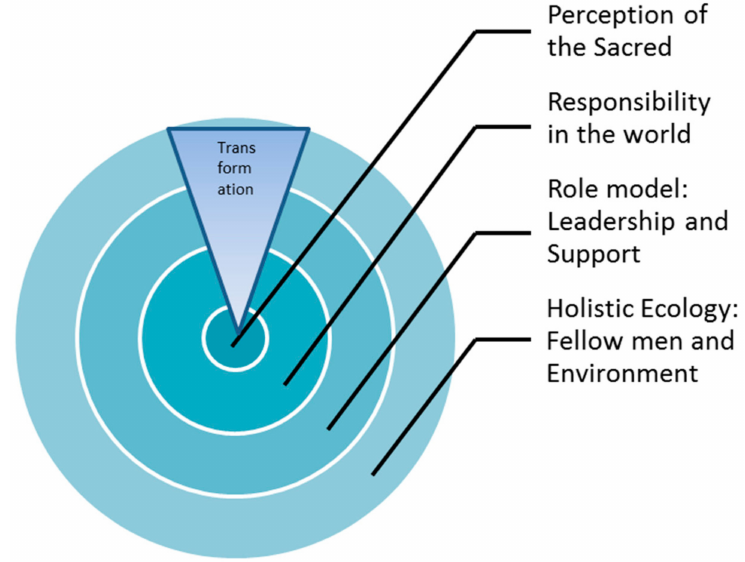
Figure 1. Transformative components of Franciscan-inspired